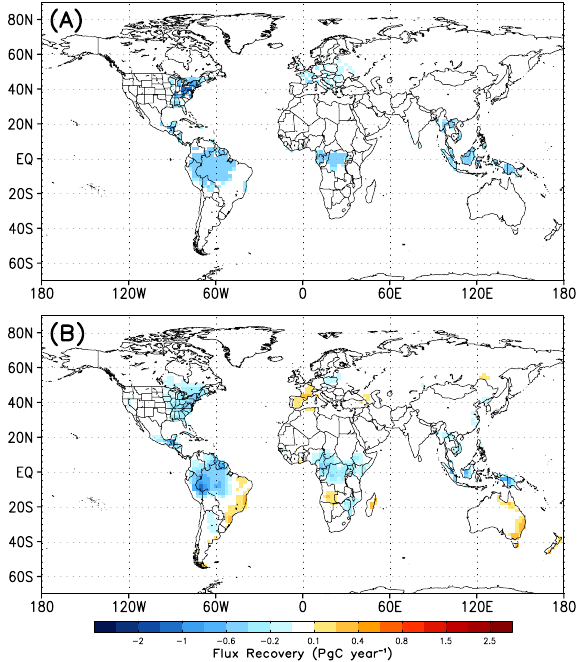
Fig. 7. (A) True and (B) recovered fluxes for Experiment 3, summed over one year.